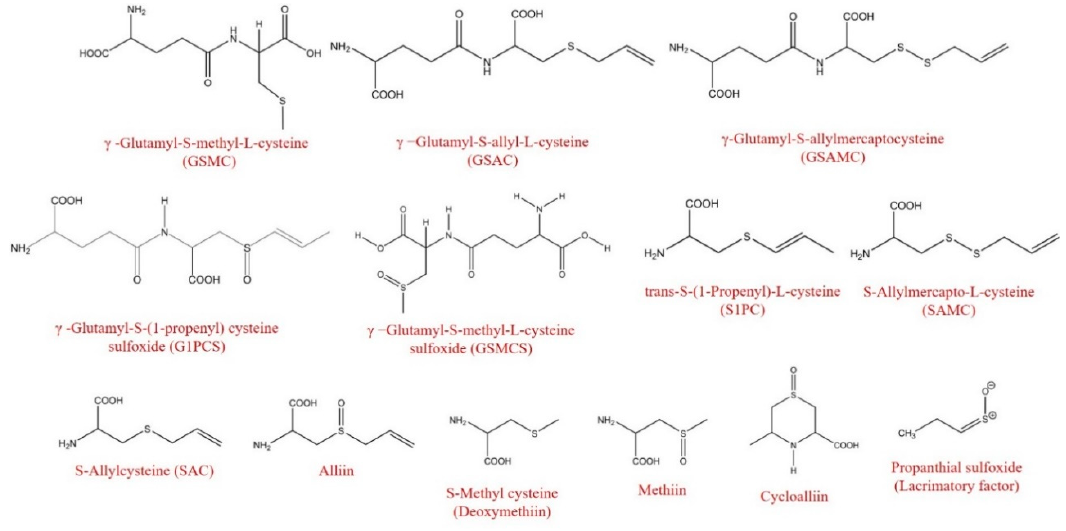
Figure 3. Chemical structures of fresh and black garlic organosulfur compounds.